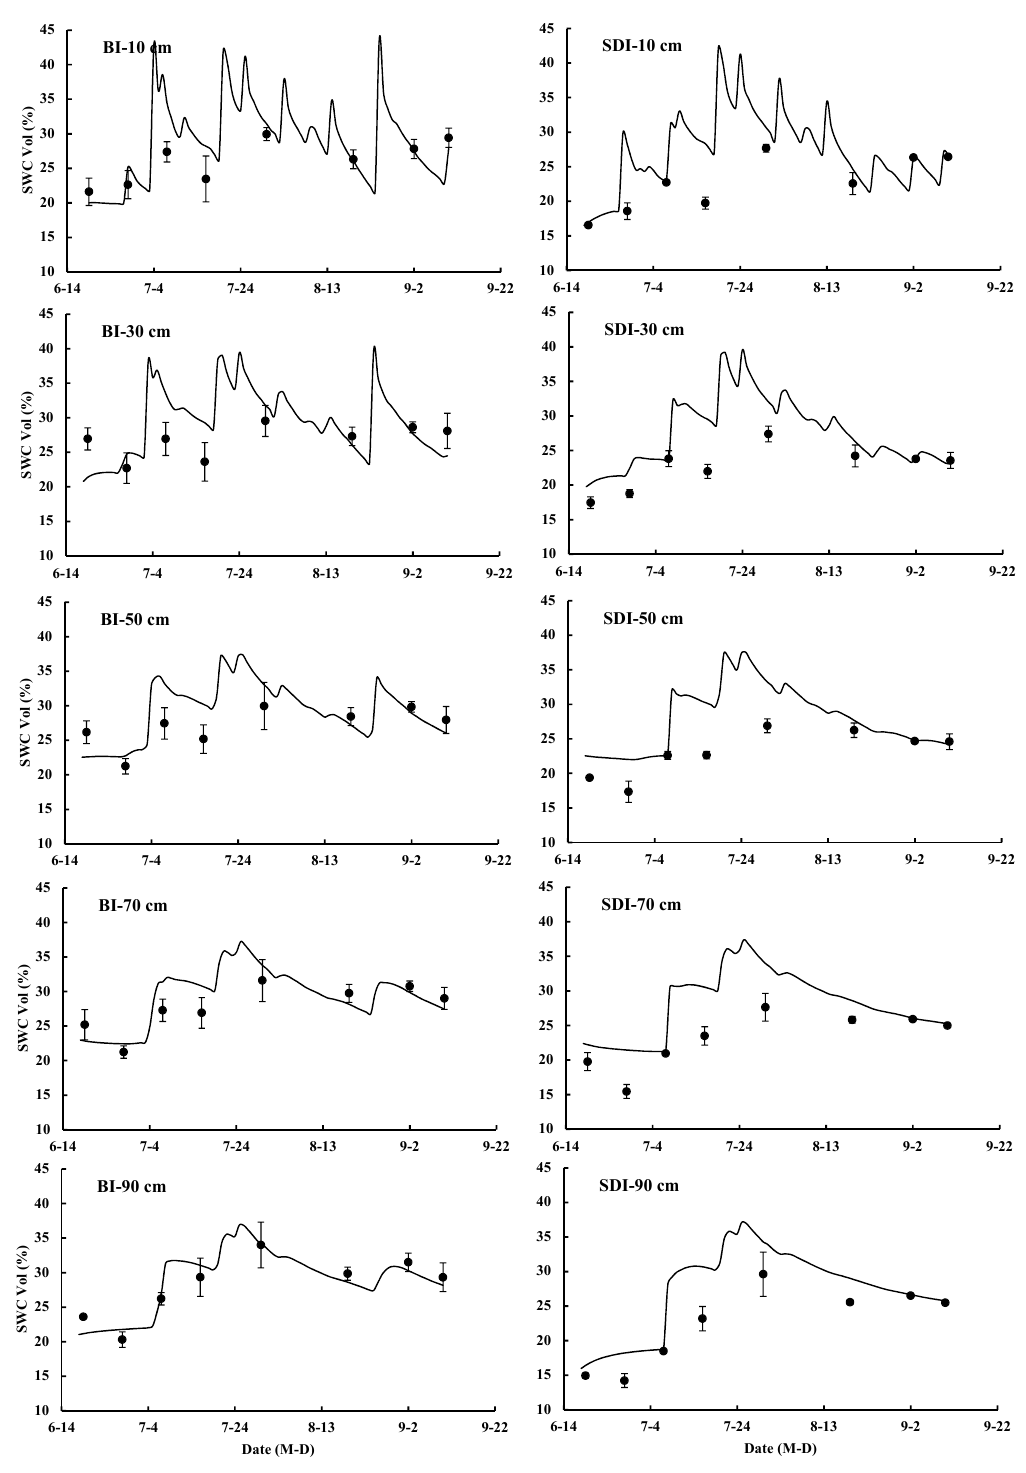
Figure 12. Simulated SWCs (lines) and measured SWCs (dots) at various depths in the middle of the inter-rows (0.35 m from the row) of cotton plants in 2013. Abbreviations: BI, border irrigation; SDI, surface drip irrigation; and SWC, soil water content. The vertical bars represent the standard errors of the means.